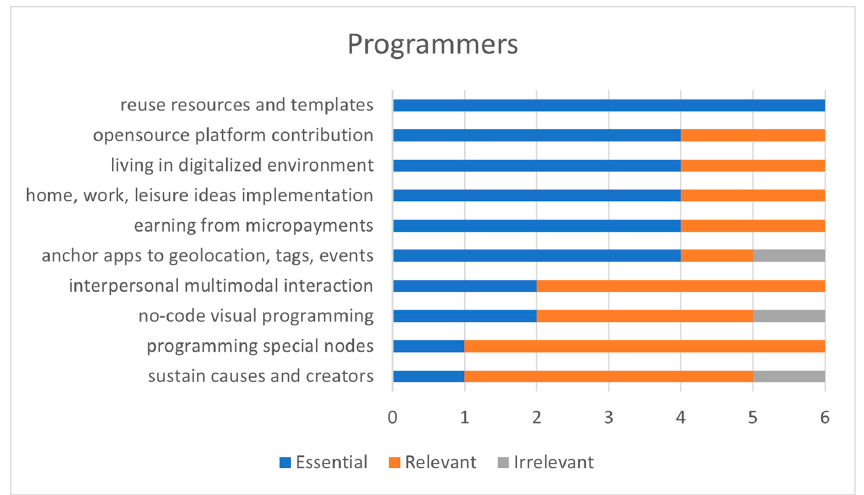
Figure 15. Most desired characteristics by programmers in order to get involved with the platform.